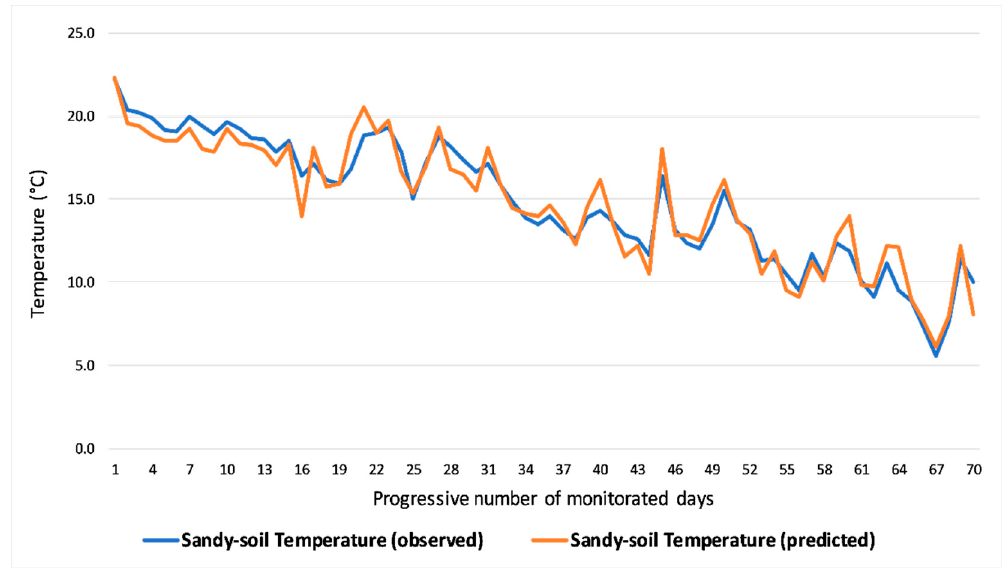
Figure 7. Comparison between measured and predicted sandy soil surface temperature during the same monitoring period.